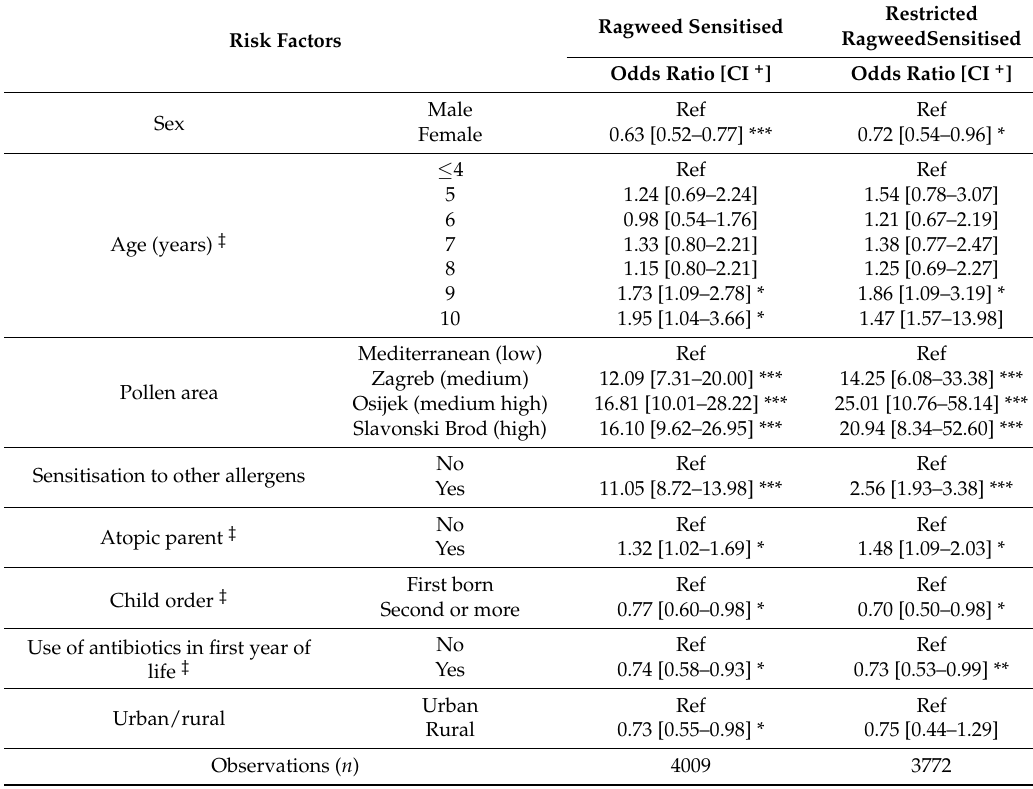
Table 3. Multivariable models for ragweed sensitised